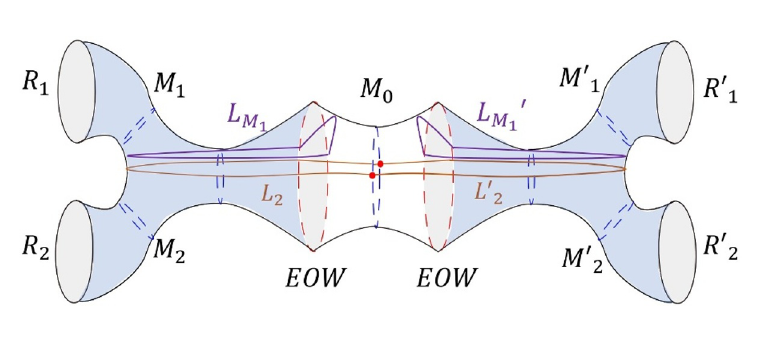
Figure 11 . The purification geometry glued through M 0 . The geodesic L 2 or L 0 parts, one in the inception geometry and the other in the original